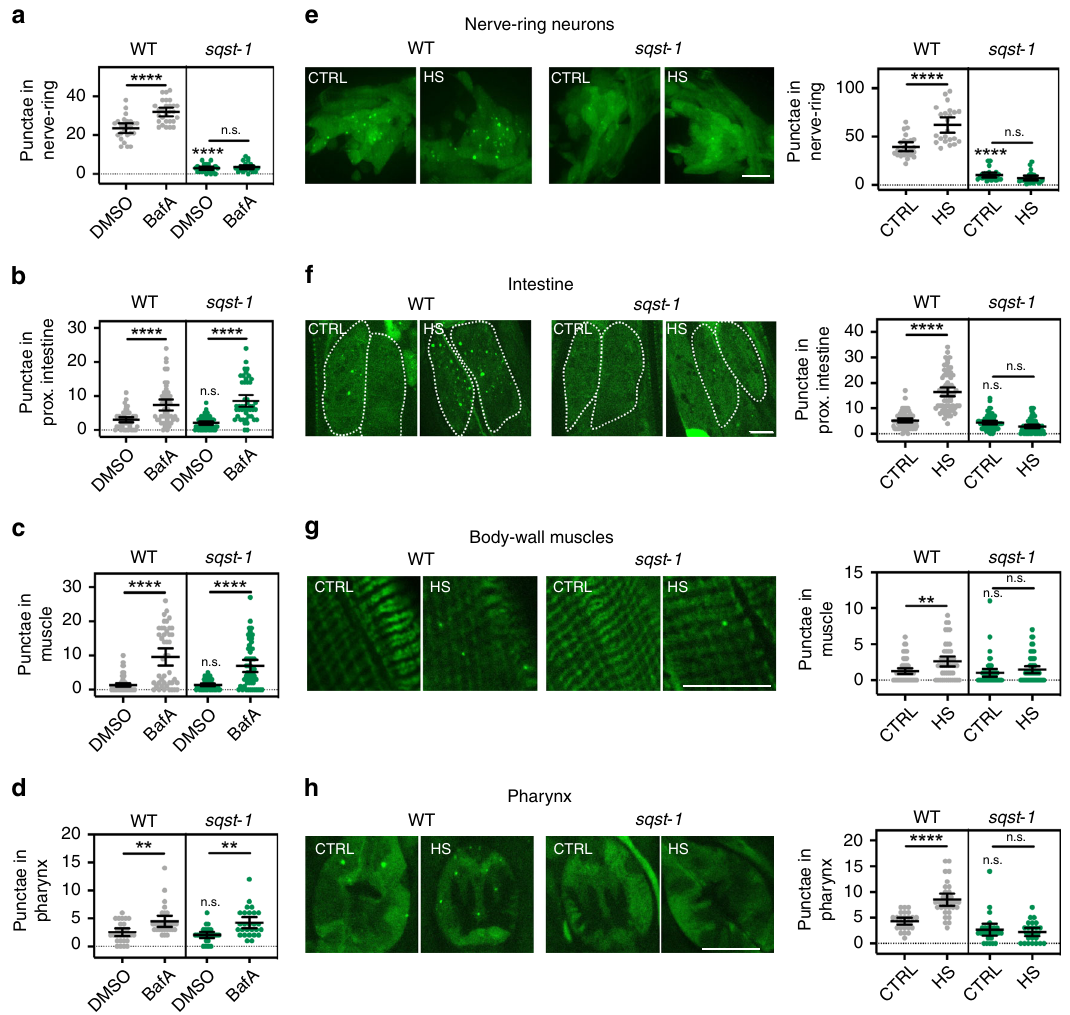
Fig. 1 sqst-1 is required for autophagy induction after hormetic heat shock (HS). a – d Autophagy fl ux was measured at 20 °C in WT and sqst-1(ok2892) ( sqst-1 ) animals on day 1 of adulthood expressing rgef-1p::gfp::lgg-1 ( a ) or lgg-1p::gfp::lgg-1 ( b – d ). WT and sqst-1 animals were injected with vehicle (DMSO) or ba fi lomycin A1 (BafA) to block autophagy at the lysosomal acidi fi cation step. GFP::LGG-1/Atg8-positive punctae were quanti fi ed from three independent experiments in a nerve-ring neurons (WT-DMSO, N = 25; WT-BafA, N = 28; sqst-1 -DMSO, N = 25, sqst-1 -BafA, N = 24 animals), b proximal intestinal cells (WT-DMSO, N = 49; WT-BafA, N = 50; sqst-1 -DMSO, N = 55, sqst-1 -BafA, N = 46 cells), c body-wall muscle (WT-DMSO, N = 71; WT-BafA, N = 44; sqst-1 -DMSO, N = 48, sqst-1 -BafA, N = 53 animals), and d and the terminal pharyngeal bulb (WT-DMSO, N = 28; WT-BafA, N = 29; sqst-1 -DMSO, N = 28, sqst-1 -BafA, N = 27 animals), Error bars indicate 95% CI. ns: P > 0.05, ** P < 0.01, **** P < 0.0001, by two-way ANOVA with Tukey ’ s multiple comparisons test. e – h GFP::LGG-1/Atg8-positive punctae were counted in WT and sqst-1(ok2892) ( sqst-1 ) animals on day 1 of adulthood expressing rgef-1p::gfp::lgg-1 ( e ) or lgg-1p::gfp::lgg-1 ( f – h ). Animals were maintained under control conditions 15 °C (CTRL) or subjected to HS for 1 h at 36 °C (HS). Animals were imaged at time of highest induction in autophagy as previously characterized 2 . GFP::LGG-1/Atg8 punctae were quanti fi ed from three independent experiments in e nerve-ring neurons (WT-CTRL, N = 24; WT-HS, N = 23; sqst-1 -CTRL, N = 23, sqst-1 -HS, N = 24 animals) with 2 h of recovery after HS, f proximal intestinal cells (WT-CTRL, N = 67; WT-HS, N = 70; sqst-1 -CTRL, N = 66, sqst-1 -HS, N = 71 cells) with 4 h of recovery after HS, g body-wall muscle (WT- CTRL, N = 60; WT-HS, N = 48; sqst-1 -CTRL, N = 50, sqst-1 -HS, N = 60 animals) (no recovery), and h terminal pharyngeal bulb (WT-CTRL, N = 26; WT- HS, N = 32; sqst-1 -CTRL, N = 26, sqst-1 -HS, N = 25 animals) with 4 h of recovery after HS. Error bars indicate 95% CI. ns: P > 0.05, ** P < 0.01, **** P < 0.0001, by two-way ANOVA with Tukey ’ s multiple comparisons test. Scale bar: 10 μ m. Source data are provided in the Source Data fi